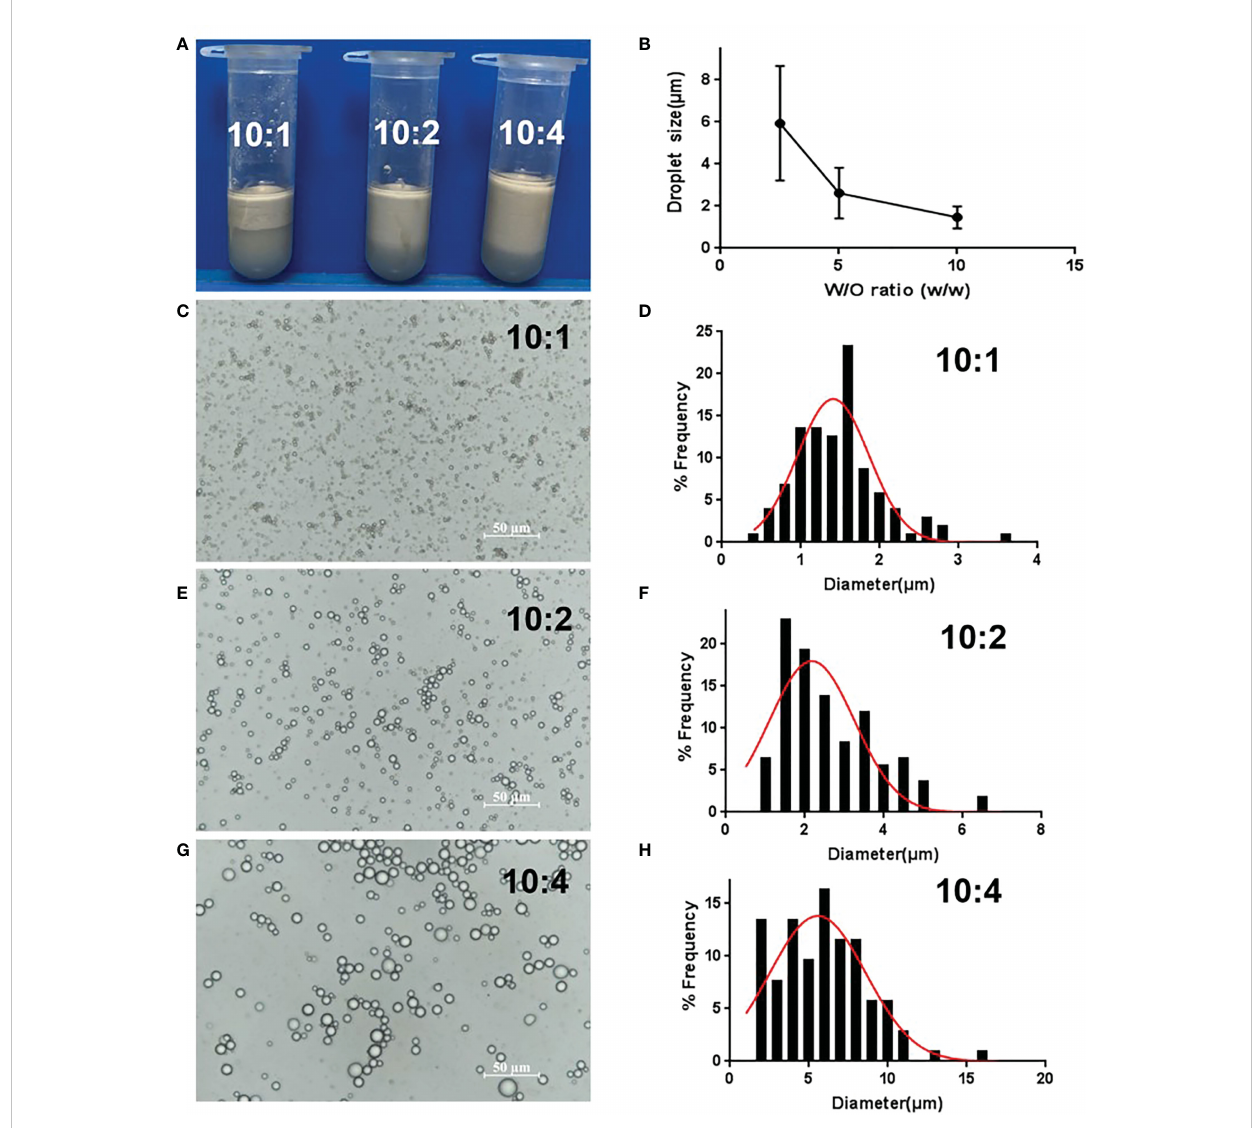
FIGURE 3 Optimization of GPE based on different water/oil ratios. (A) Appearance of GPEs prepared at different water/oil ratios; (B) the average droplet size as a function of the water/oil ratio (C, E, G) optical micrographs and (D, F, H) droplet size distributions of the GPEs prepared at different water/oil ratios. GO concentration of 1.0 mg/mL, sonication at 163 W for 2 min, natural salinity, and pH of 2 – 3. GO, graphene oxide; GPE, GO-stabilized Pickering